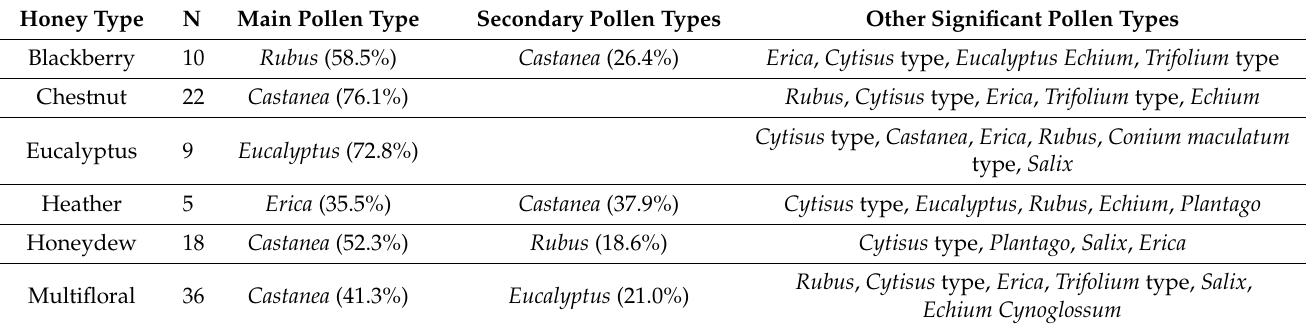
Table 4. Main pollen types identified in the samples by type